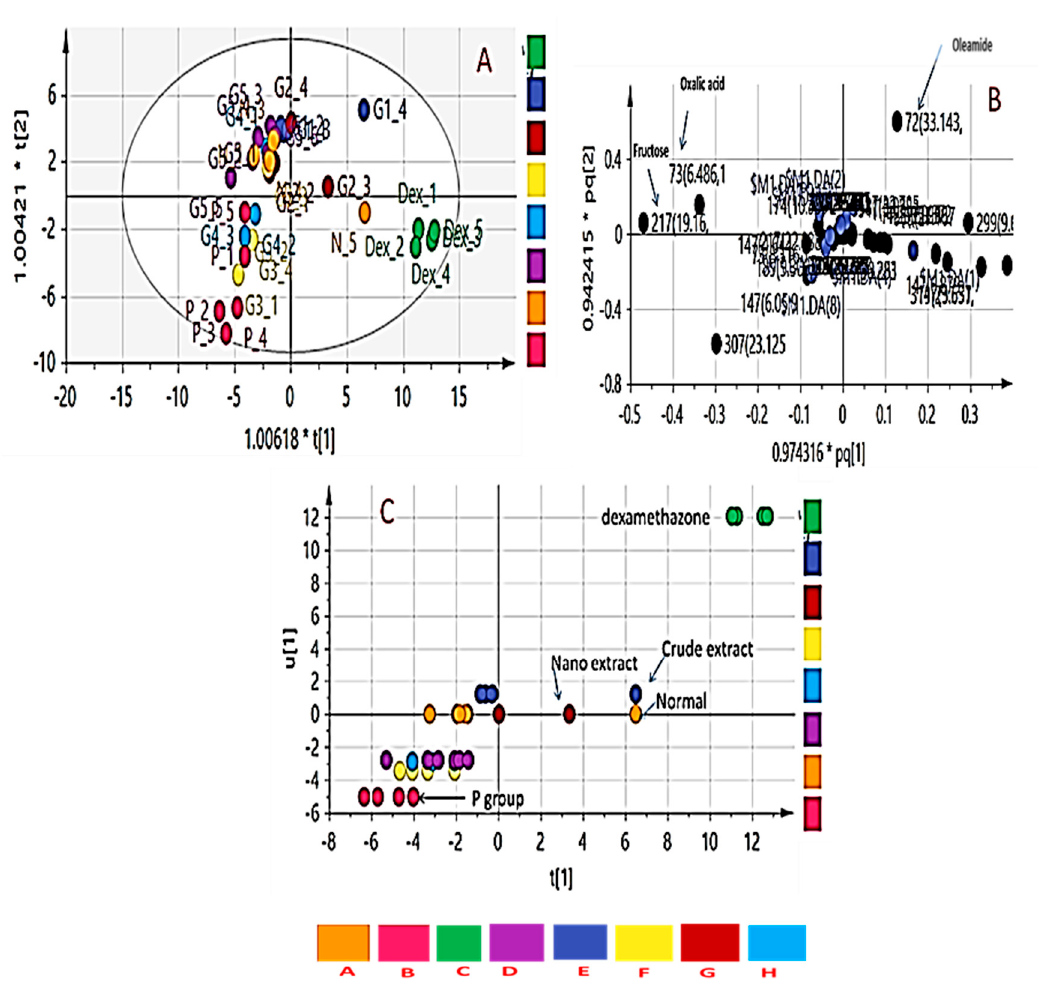
Figure 7. Orthogonal partial least-squares-discriminant analysis (OPLS-DA) score plots obtained from modelling serum metabolites detected using GCMS in the different rat groups. ( A ) Score plot showing a separation of healthy control animals, treated groups and colitis rats, ( B ) Loading plot for PC1 and PC2 components contributing peaks. ( C ) Classes inner relation of the eight rat groups with colitis group showing separation from the normal control group and treatment groups. ( A ) negative control, ( B ) positive control, ( C ) dexamethasone standard, ( D ) nano-Ag, ( E ) ASBE, ( F ) ASBE plus nano-Ag, ( G ) ASB nano-extract, and ( H ) ASB nano extract plus nano-Ag.